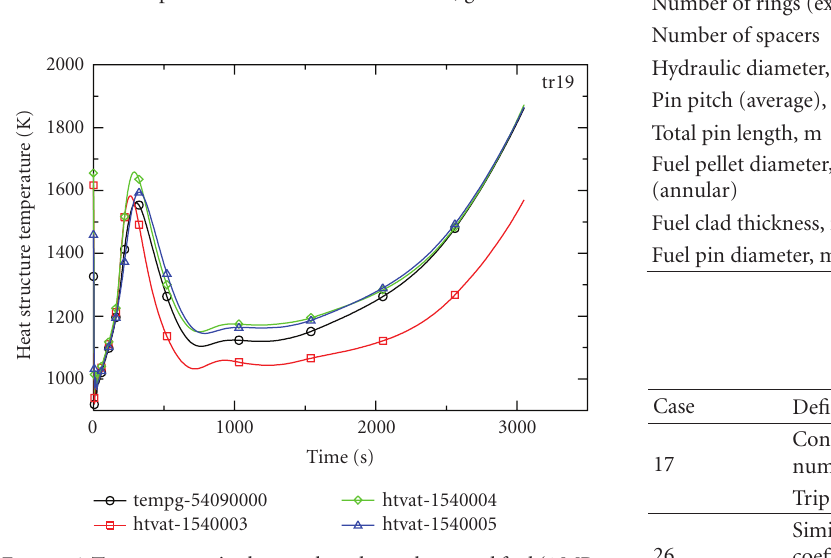
Figure 5: Temperatures in the core hot channel, gas and fuel.